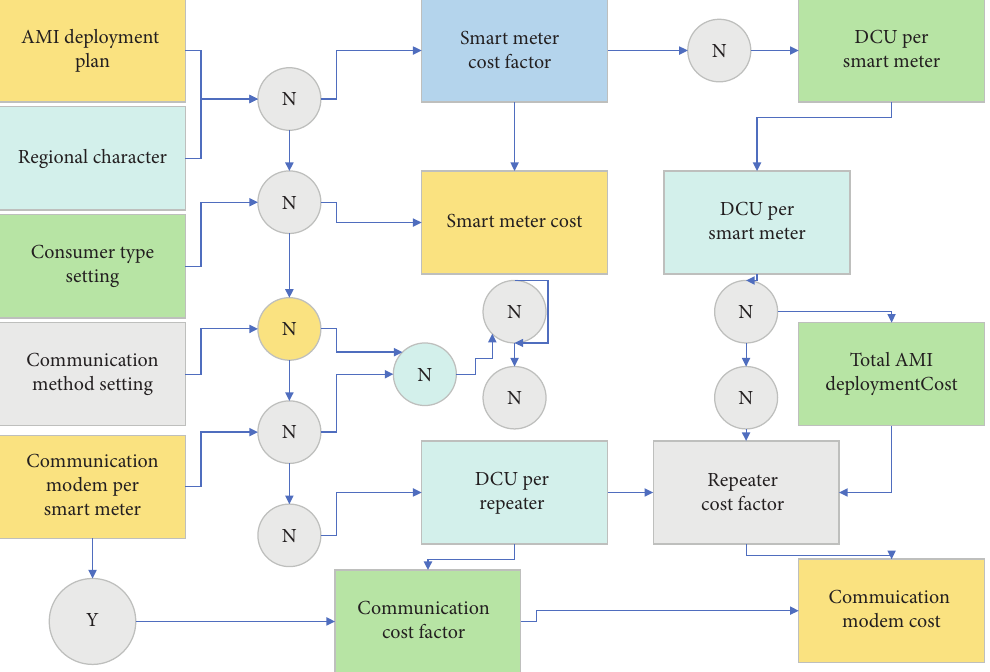
Figure 2: Simulation design of human resource